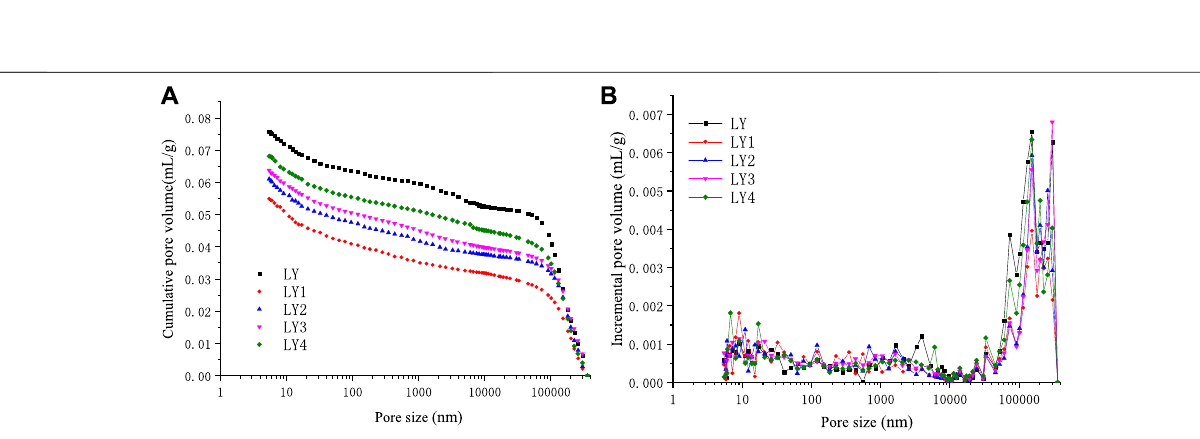
Frontiers in Earth Science |